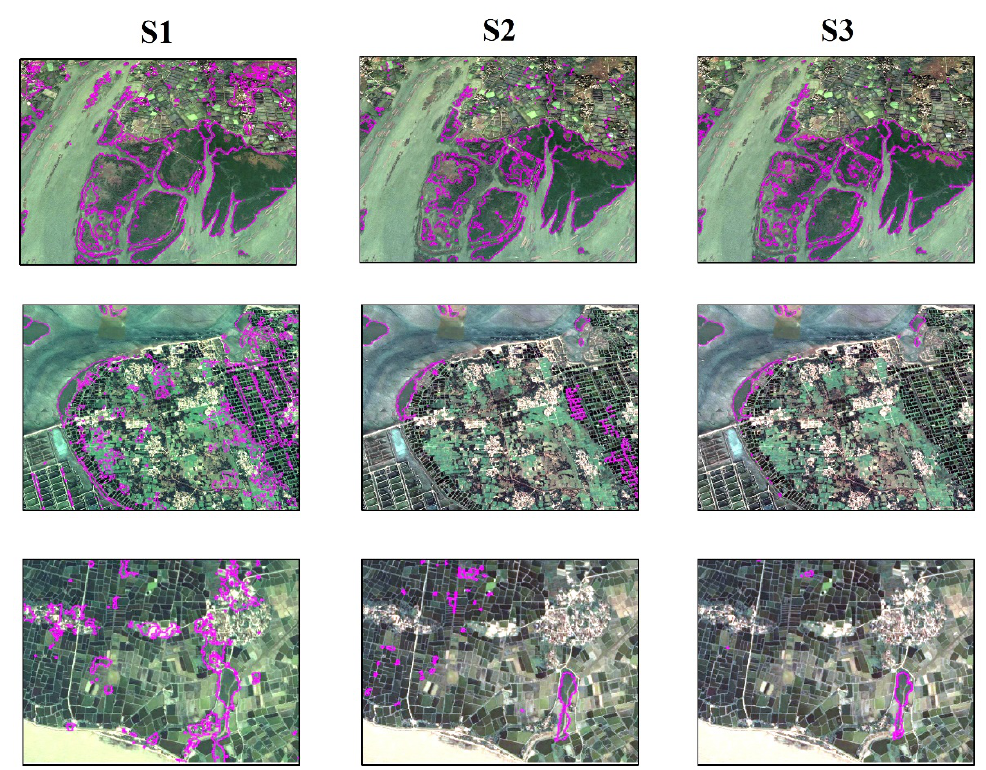
Figure 4. Subsets of classification results derived from S1, S2, and S3. The purple color represents the mangrove extraction results. S1 represents Scenario 1 using Sentinel-1 SAR imagery, S2 represents Scenario 2 using Sentinel-2 imagery, and S3 represents Scenario 3 using both Sentine-1 and Sentinel-2 data.